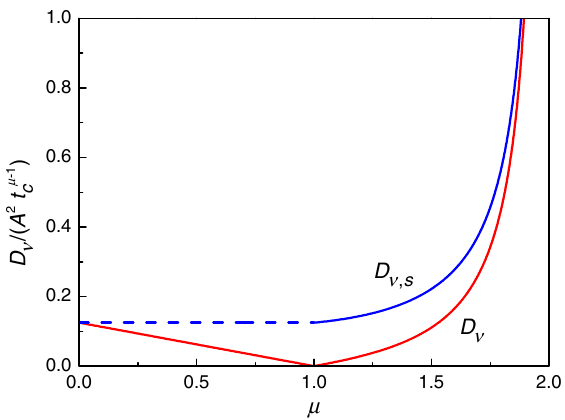
FIG. 5 (color online). The anomalous diffusion coefficient D ν = ð I 2 0 t μ − 1 c Þ for the variance of the photon number. Here, we assumed a waiting-time distribution of the form ψ ð t Þ ¼ 0 for t < ð t=t Þ − μ − 1 for t > t t and ψ ð t Þ ¼ μ =t . The stationary result D ν ; s c c c c [Eq. (54), blue line] differs from the nonstationary one D ν [Eq. (53), red line] but is finite at the transition to the aging phase μ < 1 . The blue dashed line is the result obtained for long aging times t 0 in the aging